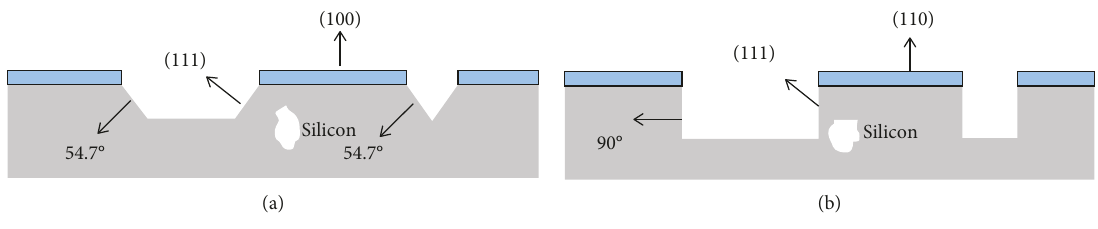
Figure 2: Etching of silicon with different crystal phases in